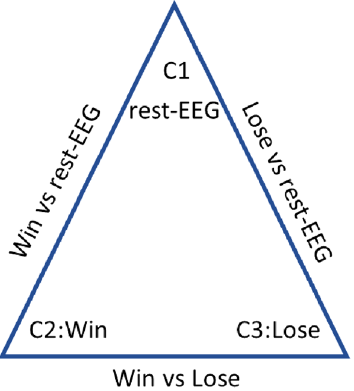
Figure 3. Diagram illustrates the three classification problems and the associated data classes collected and grouped from the EEG data collected during the third task of the proposed card game. The vertices of the triangle show the three classes, while the edges represent the three classification